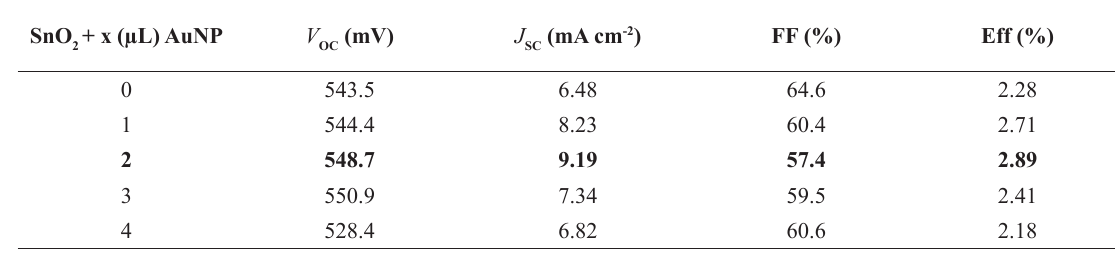
photoanodes as a function of added amounts of 2